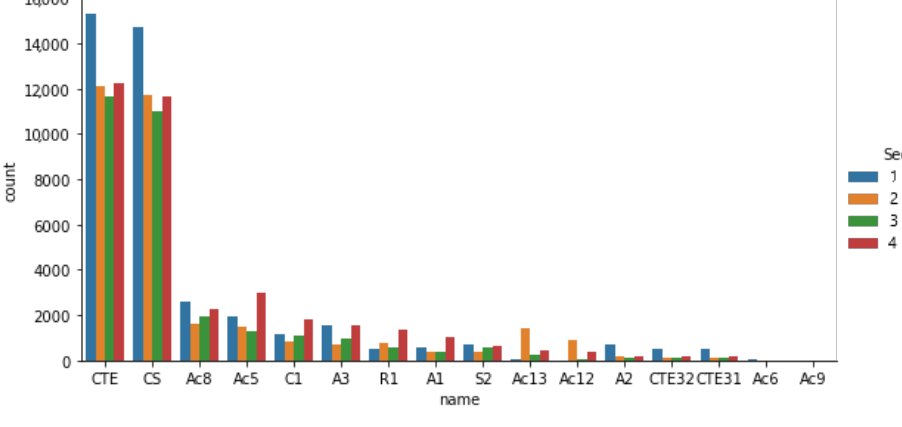
Figure 4. Actions taken by controllers according to